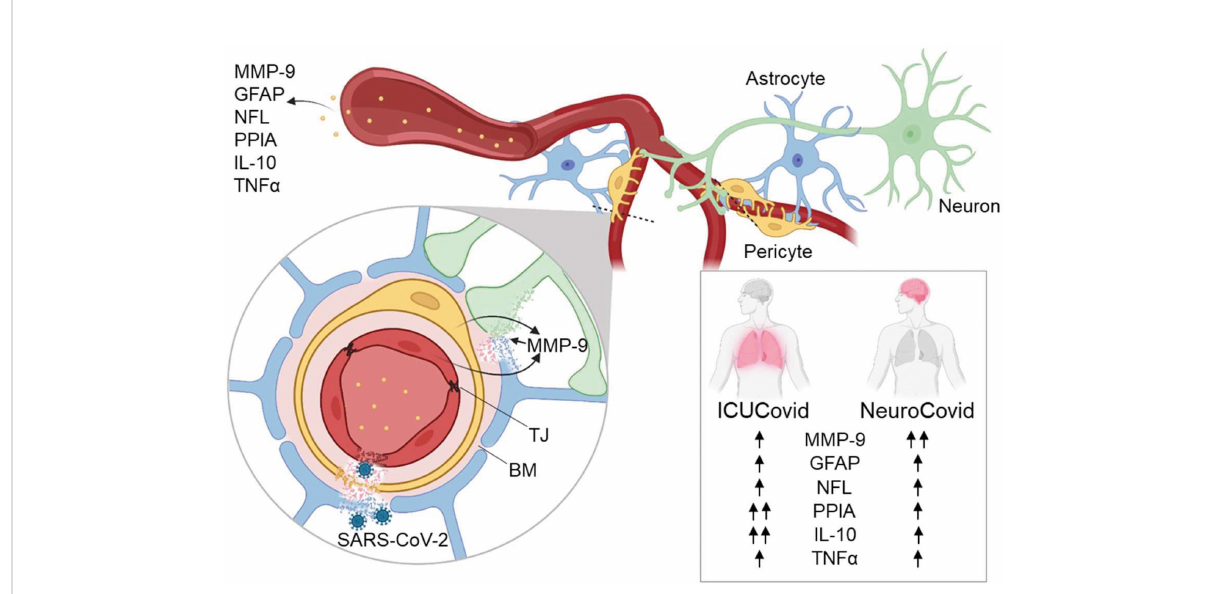
FIGURE 6 Highlights of the results. The effect of SARS-CoV-2 infection on blood biomarkers of BBB disruption (MMP-9, GFAP), neuronal damage (NFL) and systemic in fl ammation (PPIA, IL-10, TNF a ) was measured in patient cohorts with high disease severity (ICUCovid) and with neurological complications (NeuroCovid). There were higher levels of PPIA and IL-10 in ICU compared to NeuroCovid patients, while MMP-9 was signi fi cantly higher in NeuroCovid patients. Over-activation of MMP-9 may lead to degradation of tight junctions (TJ), basement membrane (BM) and laminin, implying BBB disruption, penetration of SARS-CoV-2 into the brain and neuronal damage. Blood biomarkers of BBB disruption and neuronal damage were elevated in all COVID-19 patients suggesting potential neurological dysfunctions in the long-term, over a range of disease severities. Figure created with